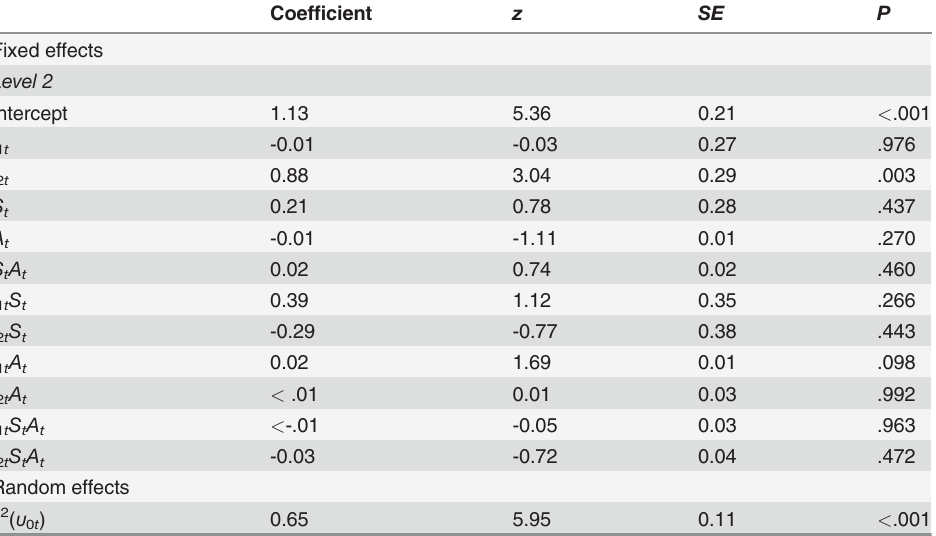
Table 6. Results of Study 1